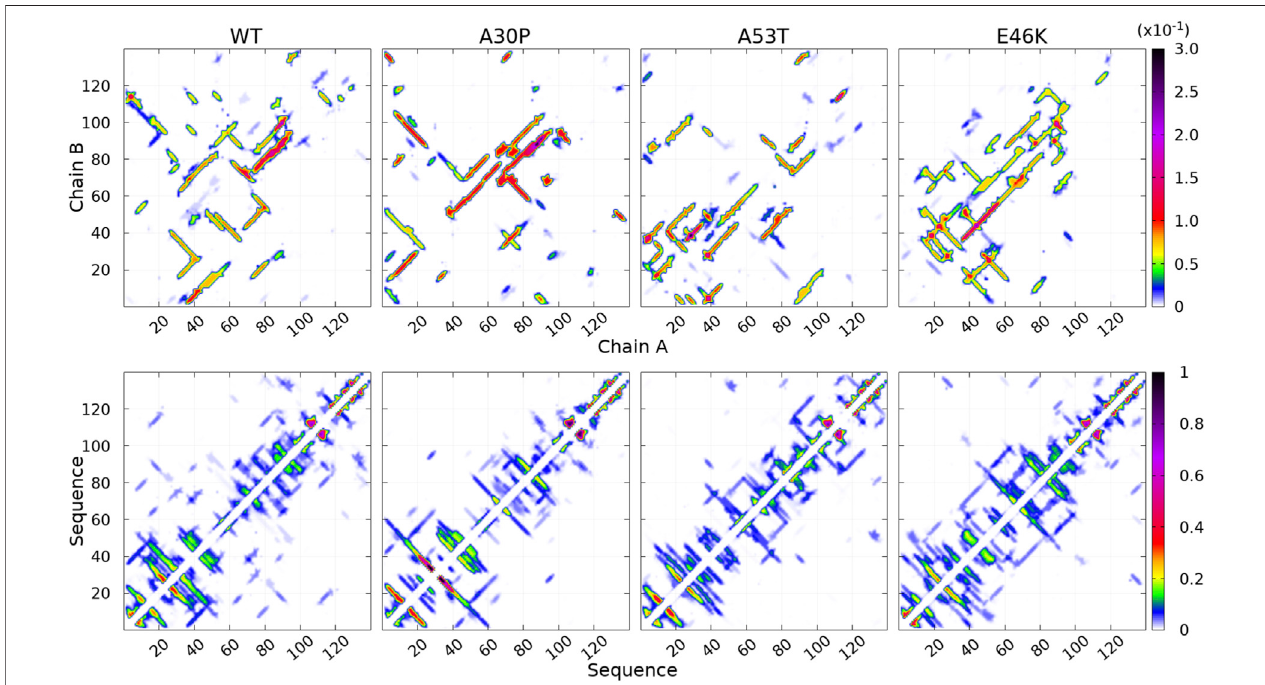
FIGURE 3 | Contact maps computed for the complete ensemble of α -syn dimers found in molecular dynamics simulations for the WT and the mutants. The upper panelsshowintermolecularcontactsbetweenchainsAand Bofthedimers, andthelowerpanelsshowintra-molecularcontactswithinmonomersA+B.Thecolorbars indicate the probability. Note the different scales for intra- and intermolecular contact